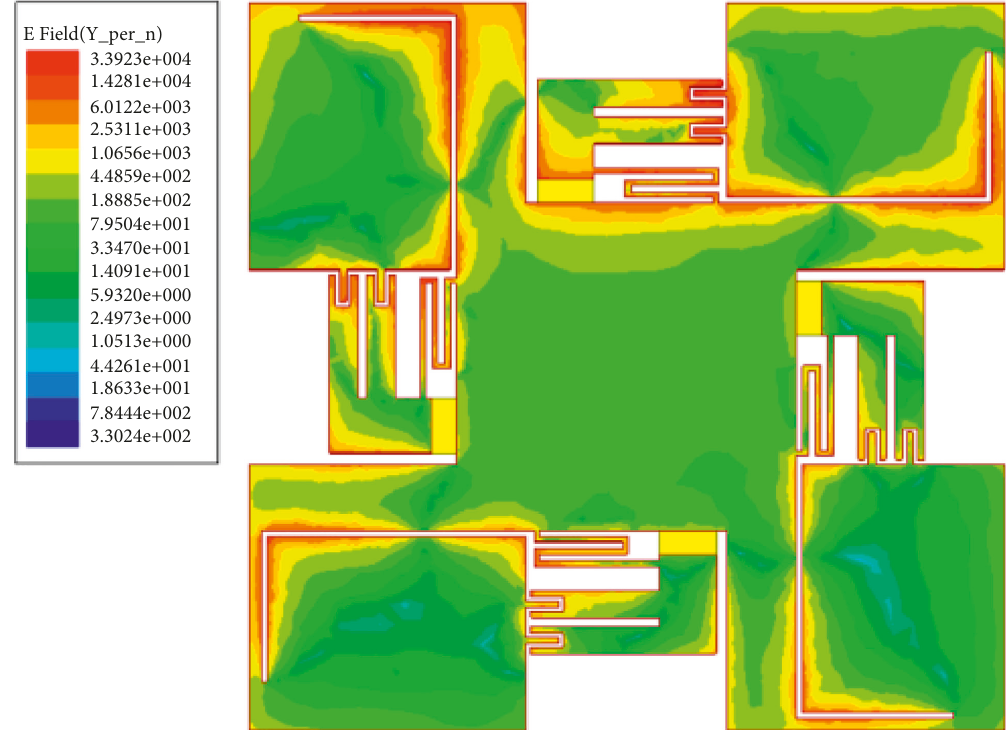
Figure 10: The simulated electric field intensity of the MIMO antenna in 3.63